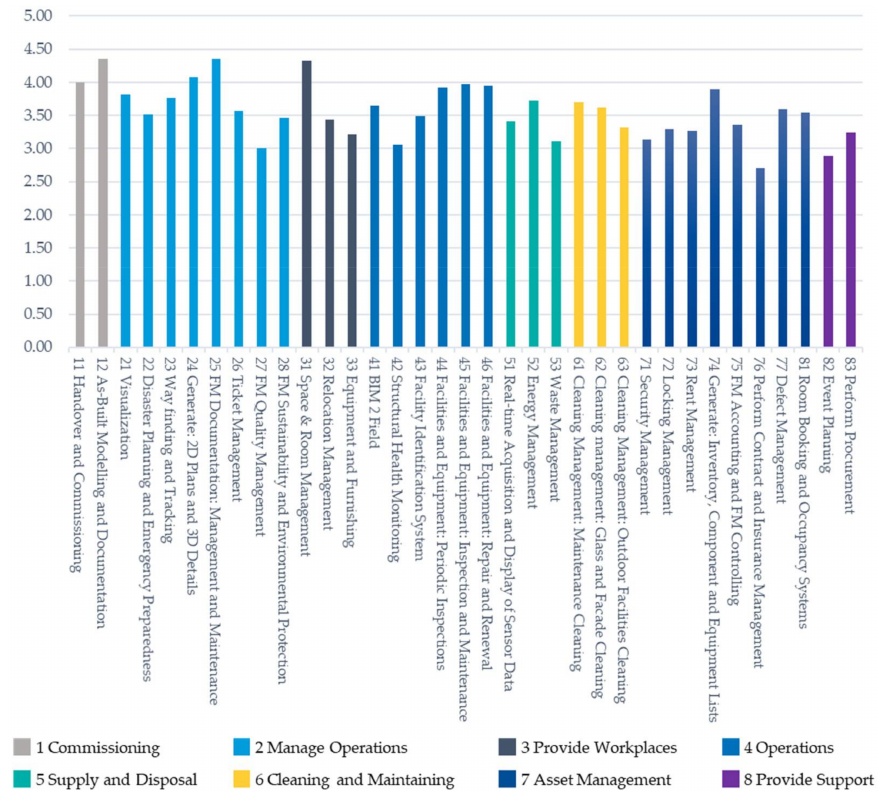
Figure 7. The arithmetic mean of BIM uses’ benefit assessments from (1—Very Low Benefit) to (5—Very High Benefit) ( n =